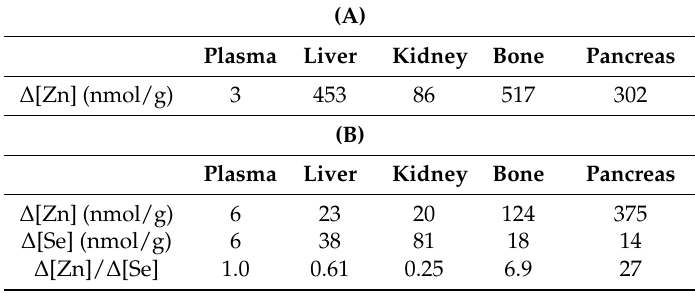
Table 4. Increased concentrations of Zn, ∆ [Zn] (nmol/g), in organs of [Zn(hmpt) 2 ]-treated mice compared with control mice ( A ), and increased concentrations of Zn and Se, ∆ [Zn] (nmol/g) and ∆ [Se] (nmol/g), and ∆ [Zn]/ ∆ [Se] molar ratios, in organs of [Zn(hmps) 2 ]-treated mice compared with control mice ( B ). (A) Plasma Liver Kidney